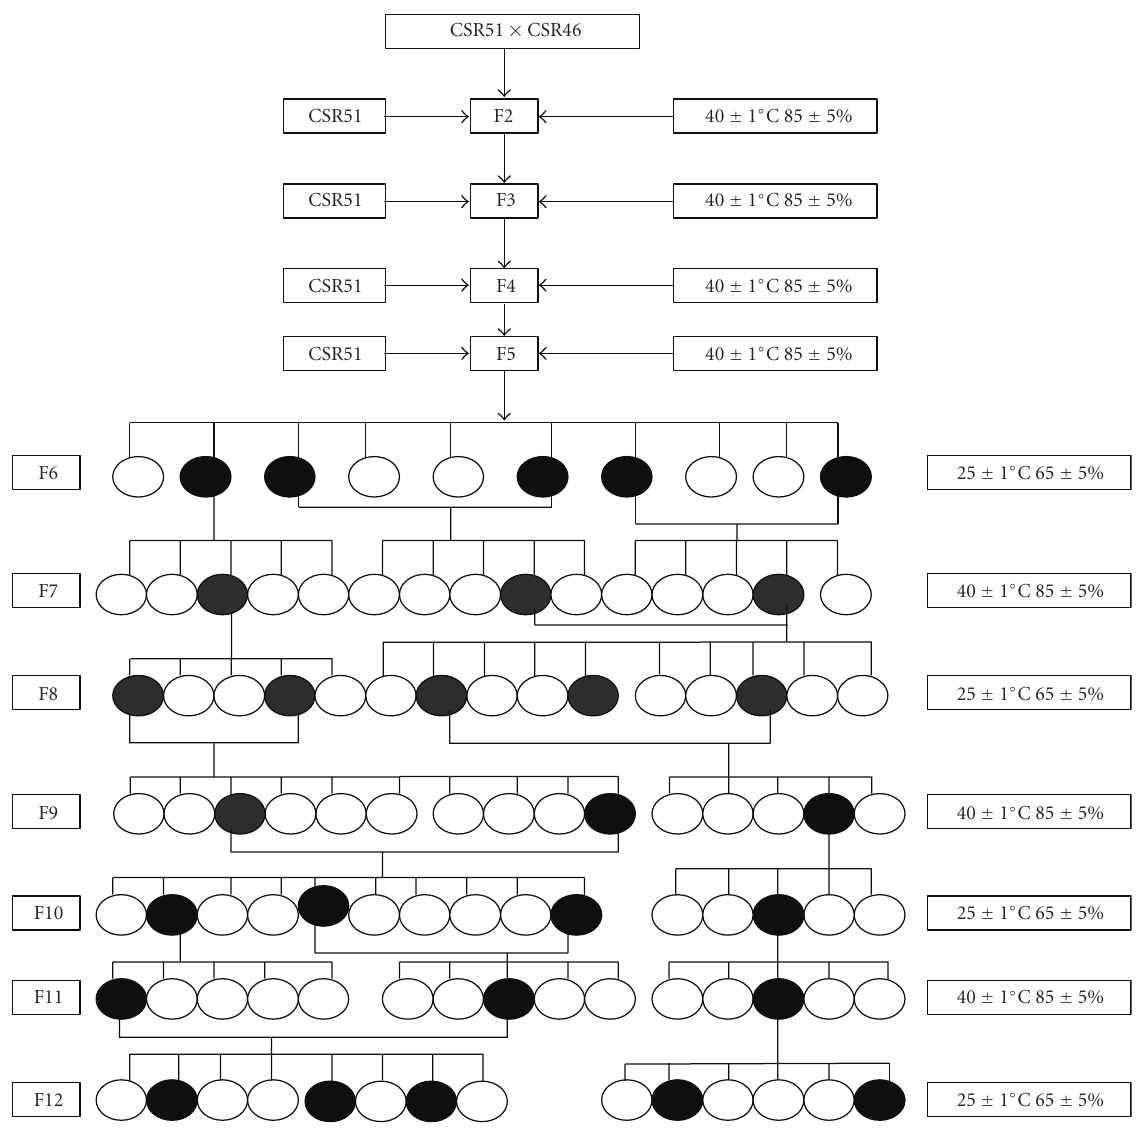
Figure 3: Breeding plan for